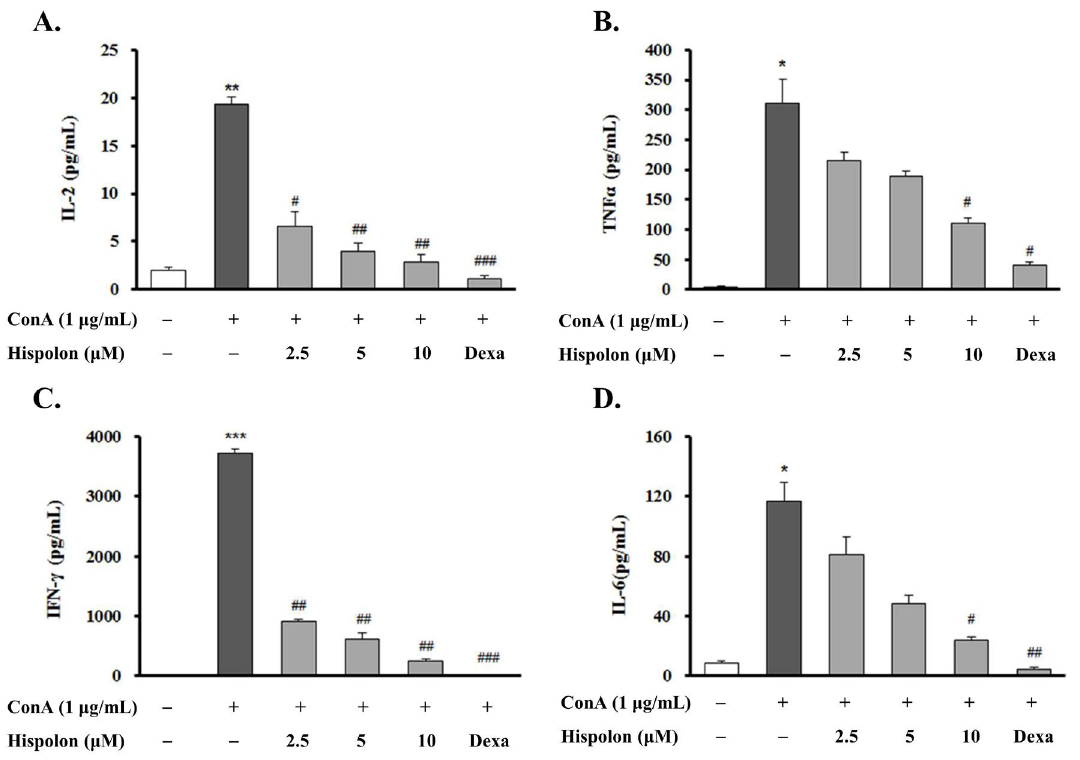
Figure 7. Effect of hispolon on the levels of Th1/Th2/Th17 cytokines in ConA-treated splenocytes. Cells were pretreated with 2.5, 5, or 10 μM hispolon and then stimulated with 1 μg/mL ConA for 3 days. The culture medium was subjected to a CBA assay to detect the levels of Th1/Th2/Th17 cytokines. The levels of the Th1 cytokines ( A ) IL-2, ( B ) TNF- α , and ( C ) IFN- γ , and the Th2 cytokine ( D ) IL-6 were measured in response to hispolon treatment. Dexamethasone (Dex) served as a positive control. Each value represents the mean ± SD of three measurements performed in triplicate ( n = 3). Significance was analyzed using one-way ANOVA; * p < 0.05, ** p < 0.01, and *** p < 0.001, vs. the control group; # p < 0.05, ## p < 0.01, and ### p < 0.001, vs. the ConA-treated group.